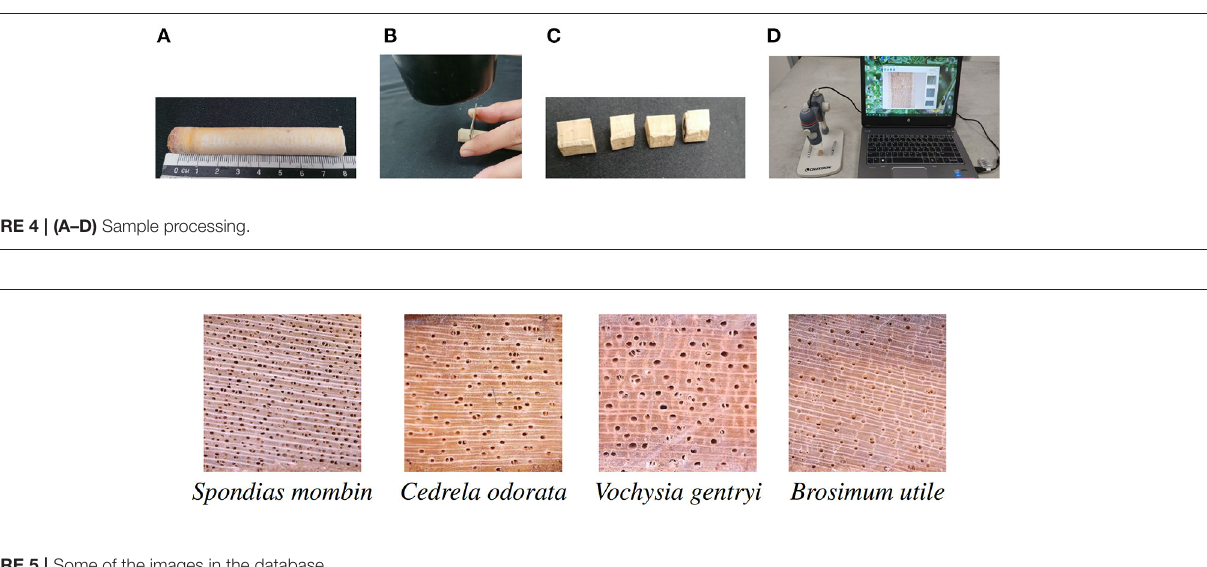
FIGURE 5 | Some of the images in the